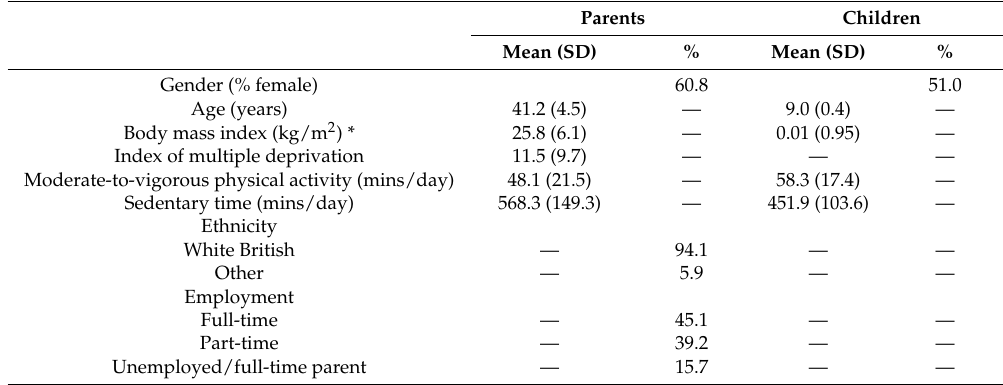
Table 1. Demographic characteristics of the interview sample of parents ( n = 51) and their children.